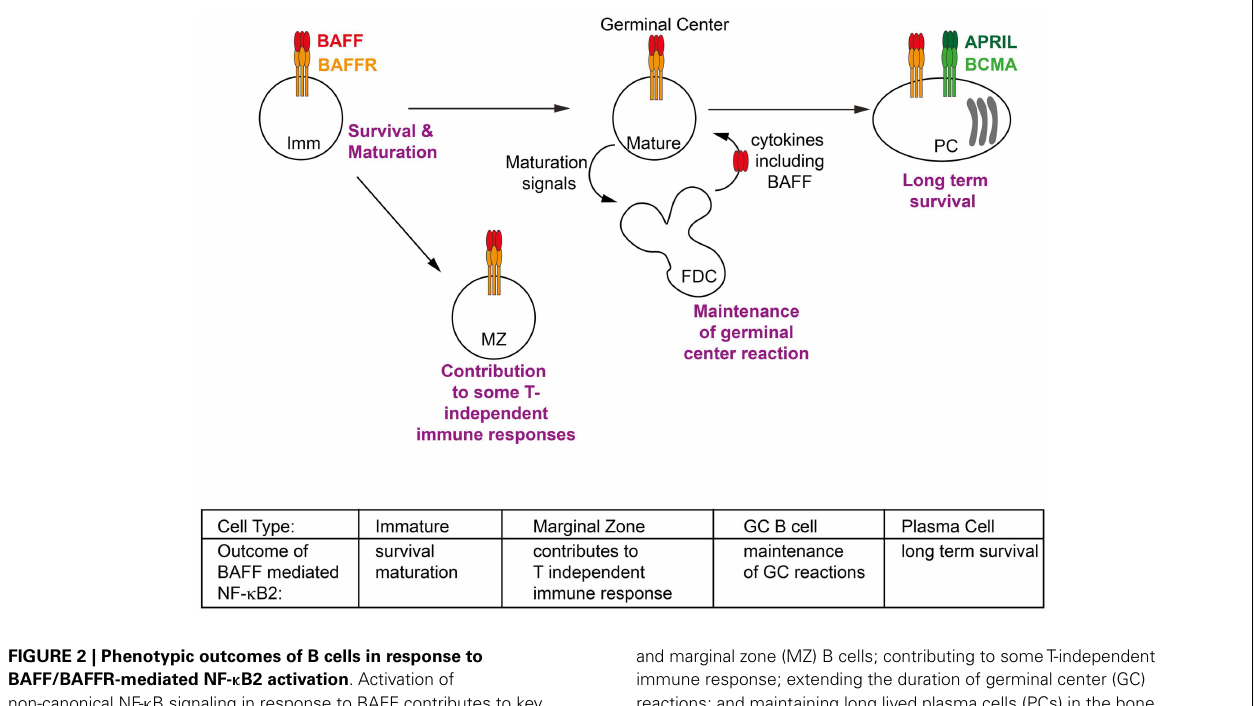
FIGURE 2 | Phenotypic outcomes of B cells in response to BAFF/BAFFR-mediated NF- κ B2 activation . Activation of non-canonical NF- κ B signaling in response to BAFF contributes to key events throughout the lifespan of a B cell.These include facilitating the survival of immature (Imm) B cells in the periphery and activating transcriptional programs which allow them to mature into follicular